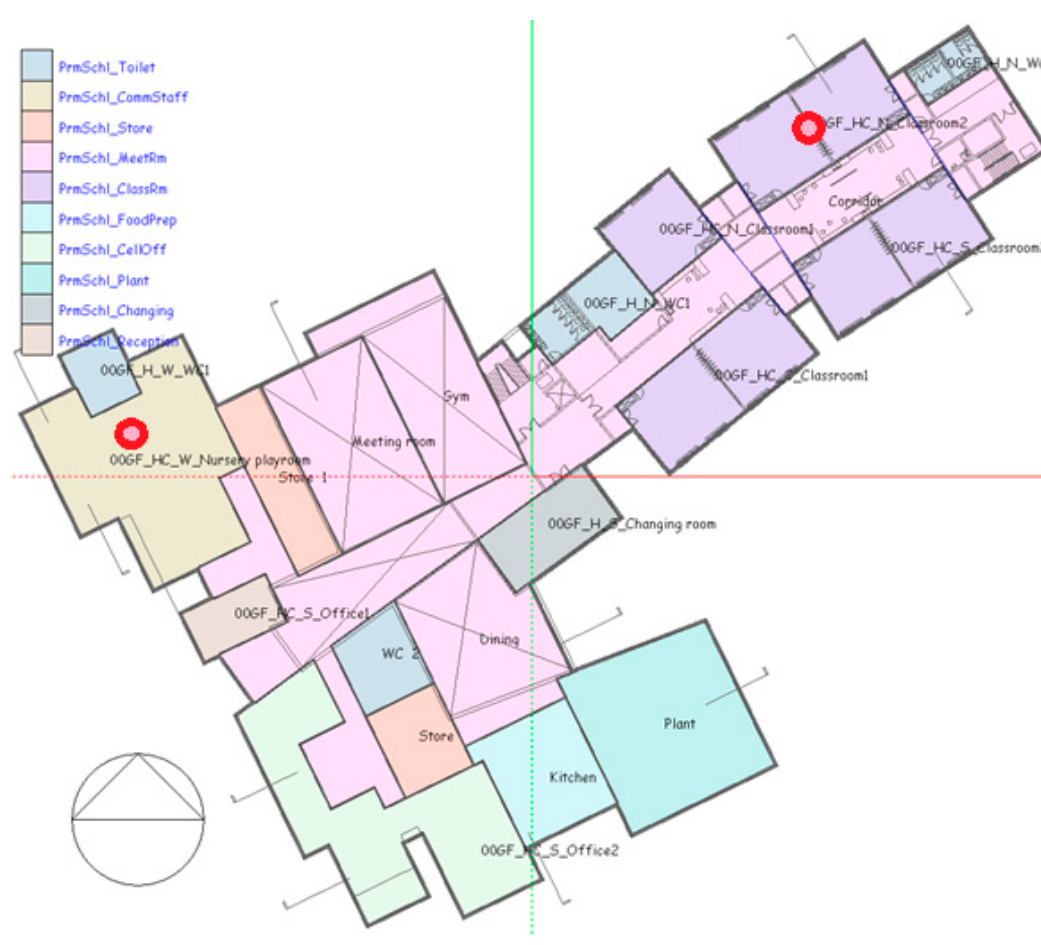
Figure 3. Floor plan of test building.